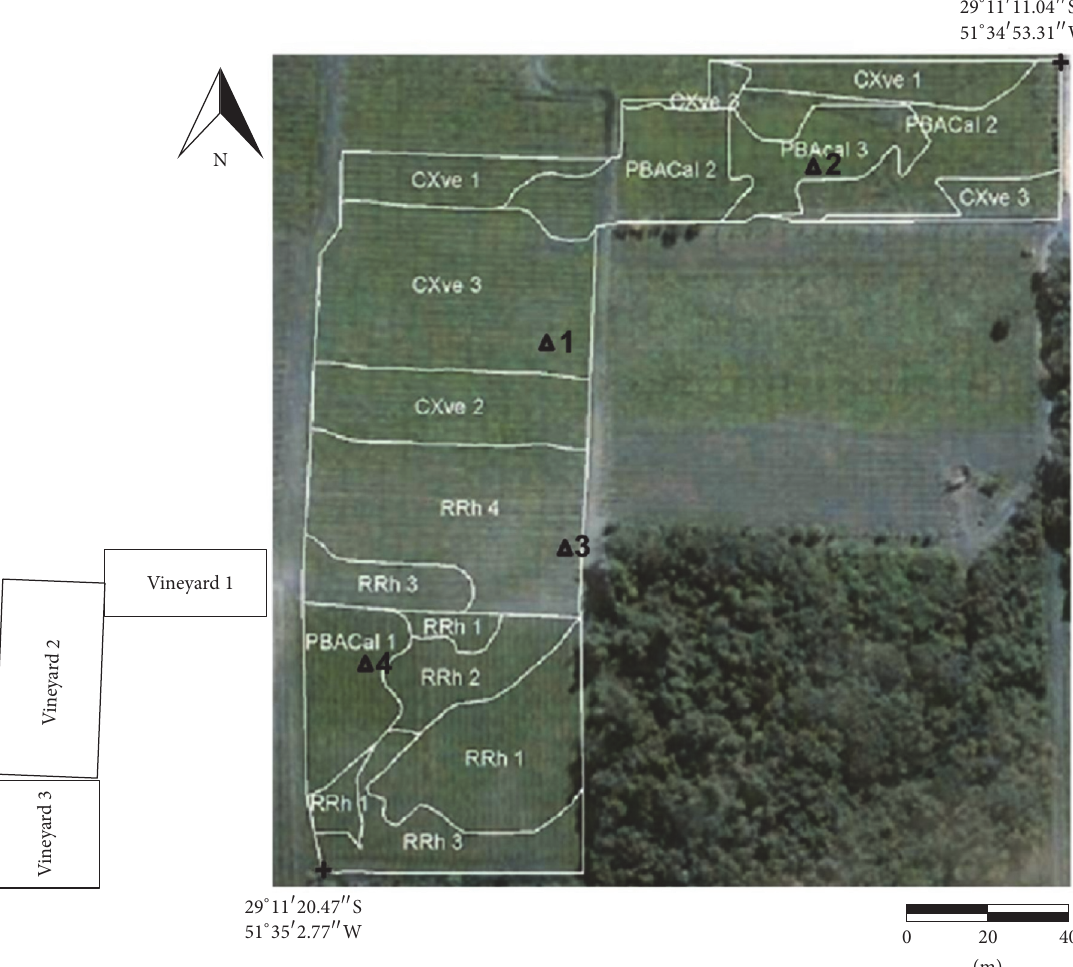
Figure 1: Map of soils of the study area on the orbital image as background (Google Earth (cid:2) , 2013). Triangles indicate the location of the soil